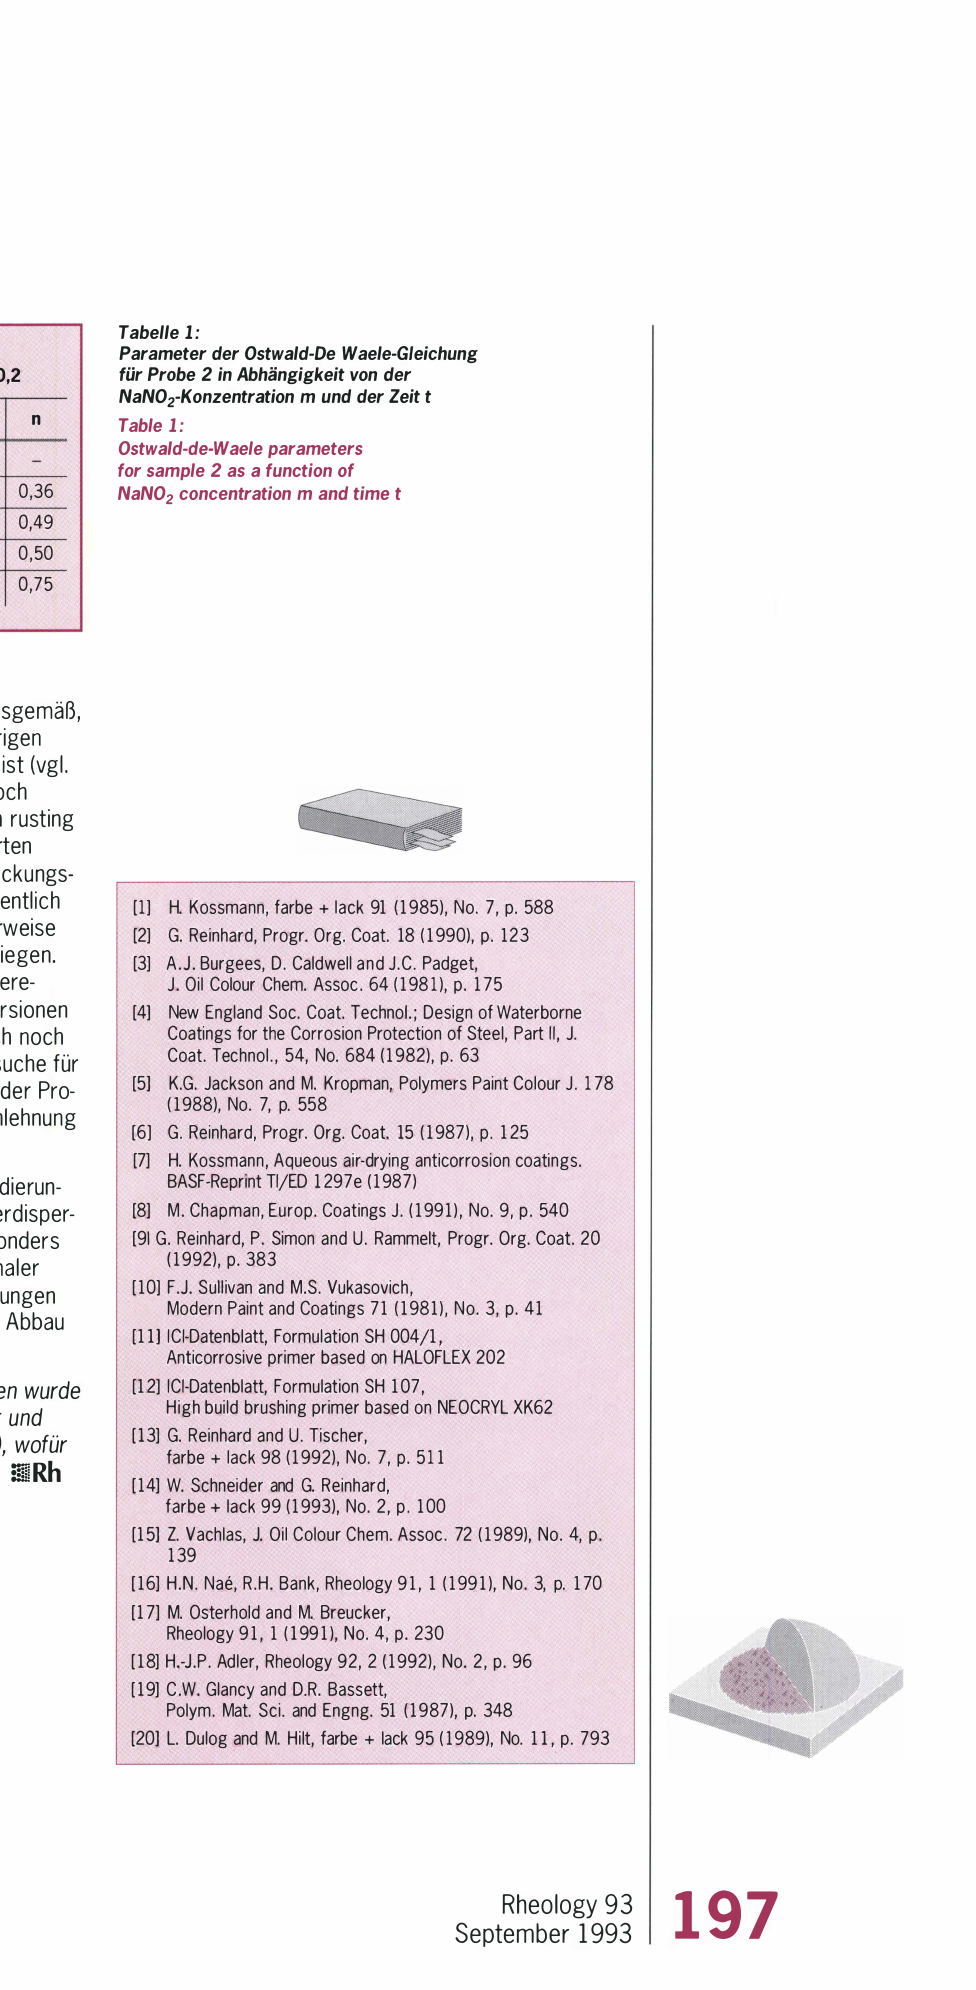
Tabel/e 1: Parameter der Ostwald-De Waele-Gieichung